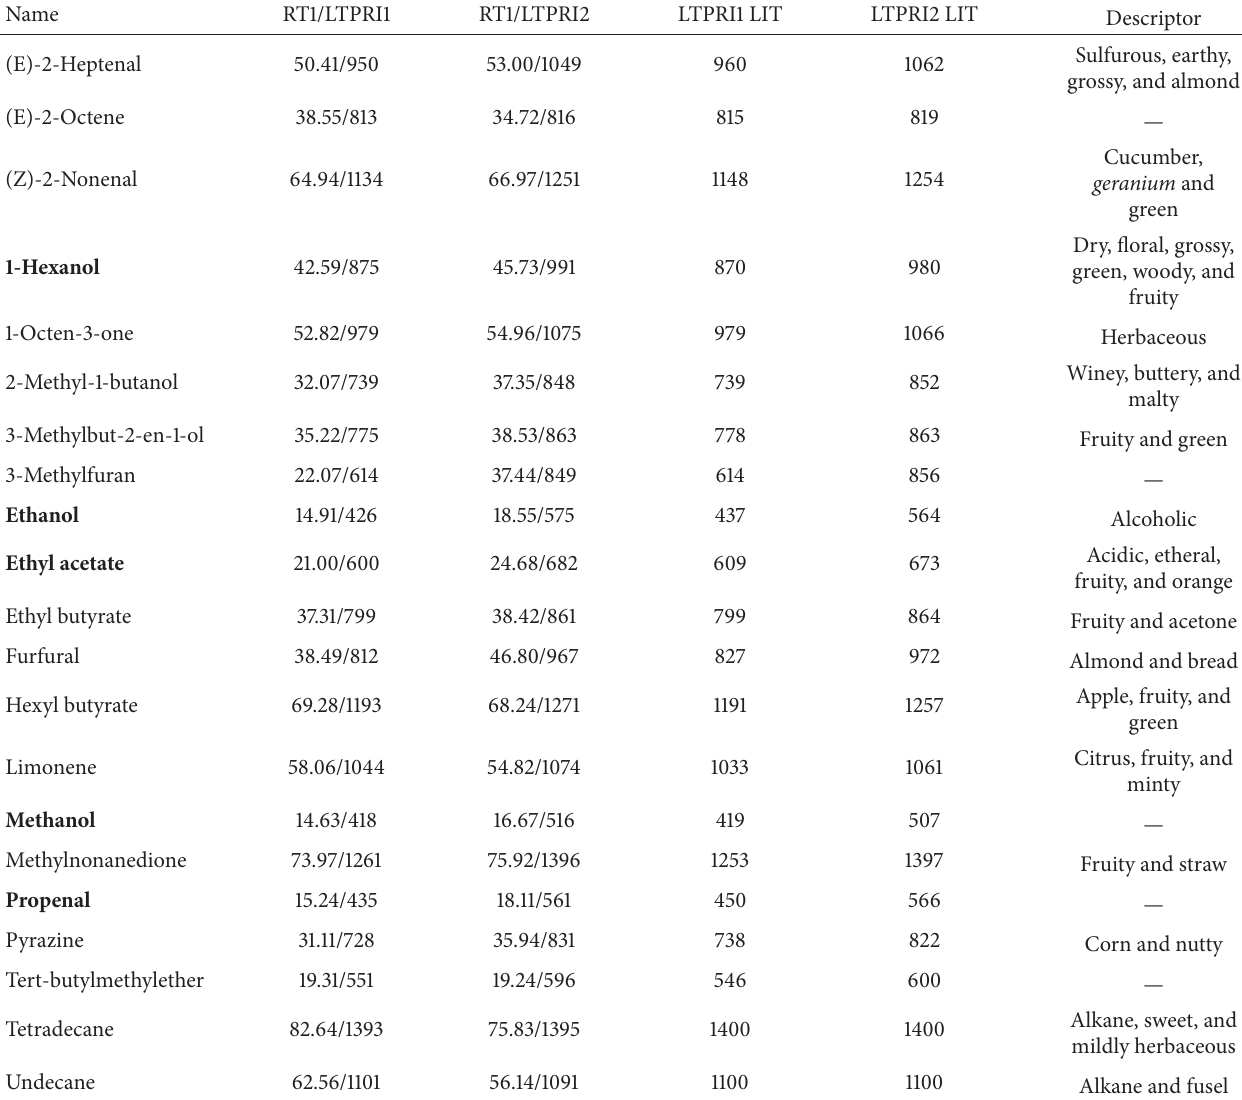
Table 3: Compounds detected in vodka